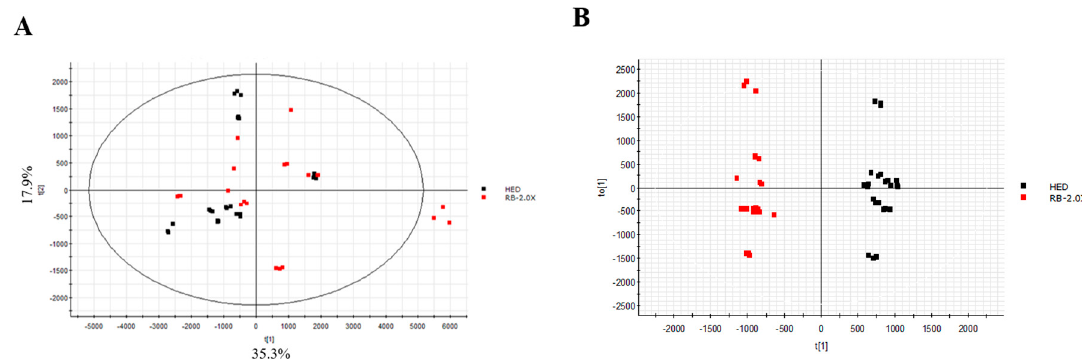
Figure 4. Score plots of the serum samples from the HED and RB-2.0X groups. ( A ) PCA score plot and ( B ) OPLS-DA score plot. HED, SD rat fed HED; RB-2.0X, SD rat fed HED with RB-2.0X.